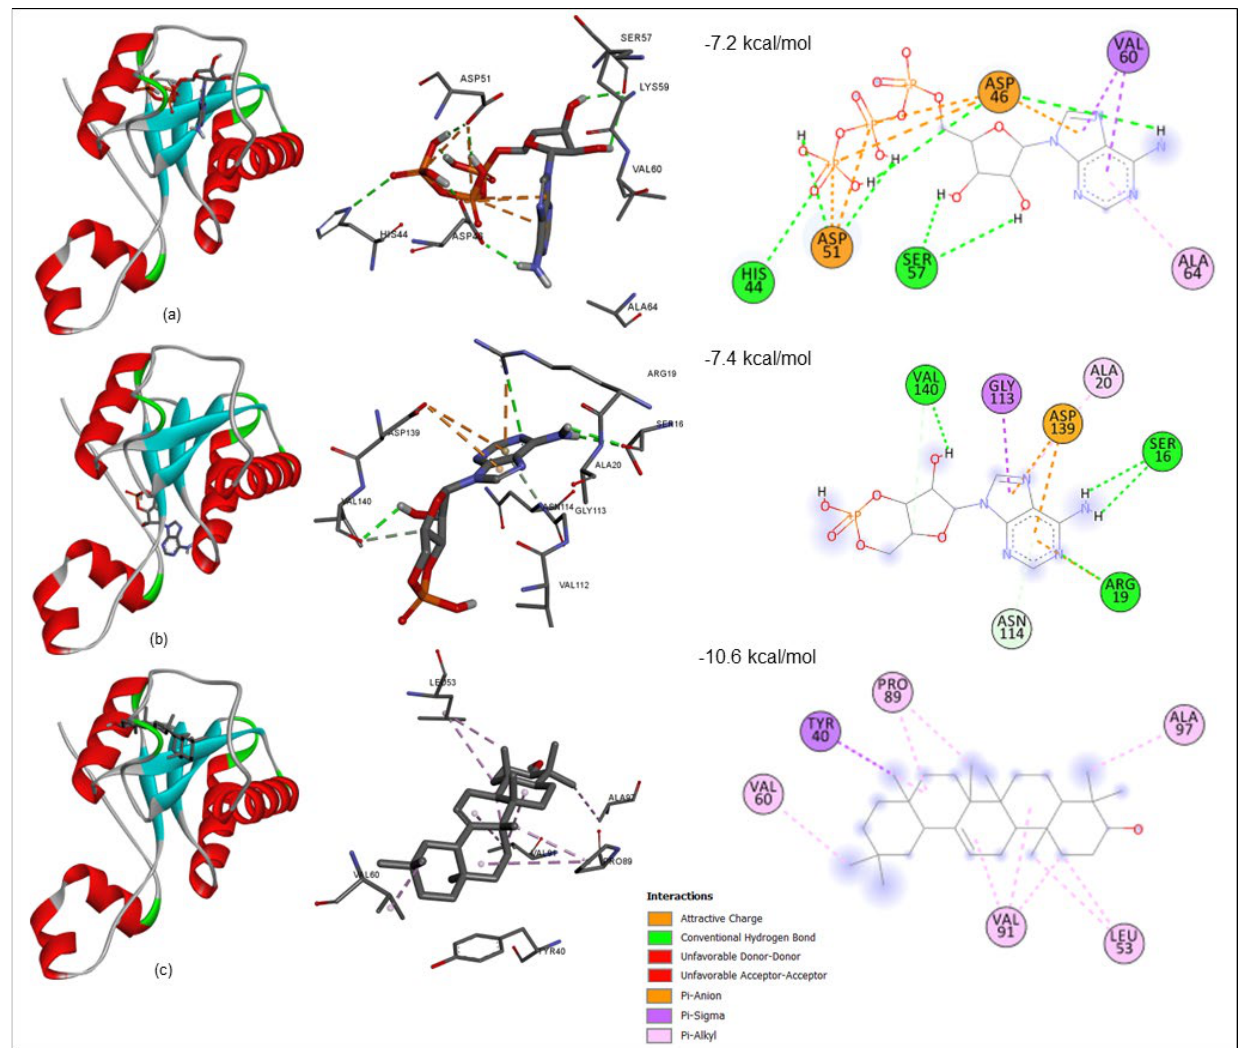
Figure 3. Docking interaction studies of 2-D structural representation of protein–ligand complexes. ( a ) Rv1636 with ATP; ( b ) Rv1636 with cAMP; ( c ) Rv1636 with β -Amyrin having pi-Alkyl bonds (purple) and Hydrogen bond (green) with their interacted residues.